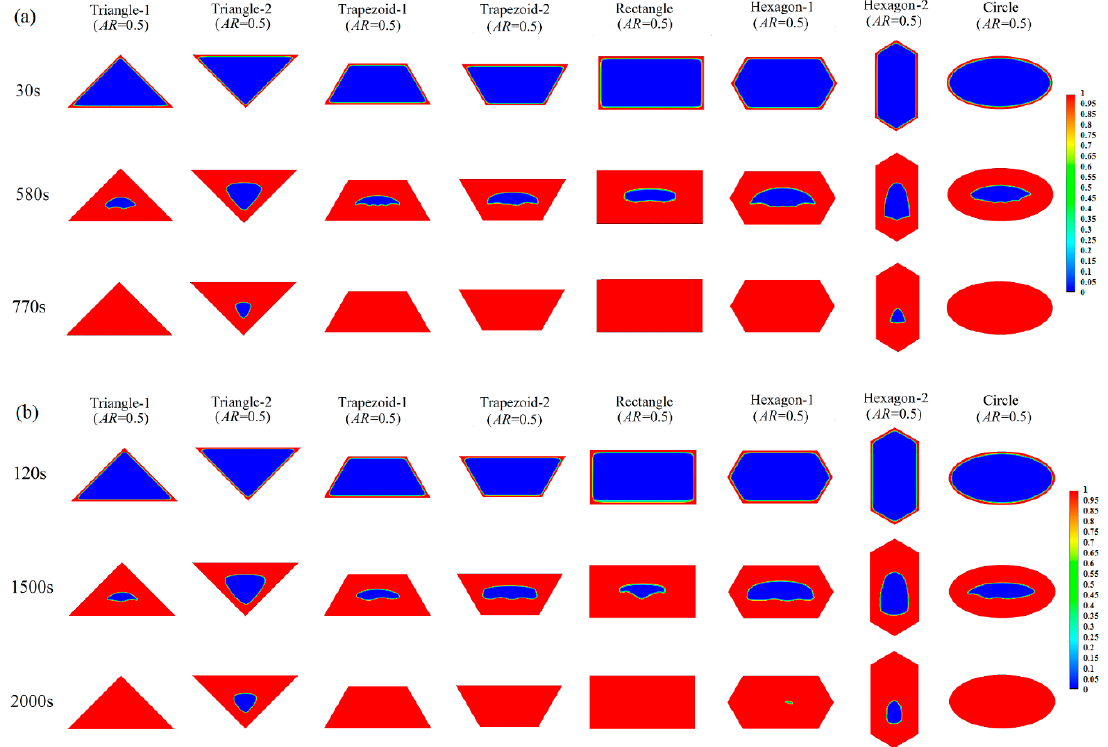
Figure A3. Liquid fractions of the triangular, trapezoidal, rectangular, hexagonal, and circular cells with smaller aspect ratios ( AR = 0.5). ( a ) Ra = 4.83 × 10 6 ( A = 625 mm 2 ); ( b ) Ra = 3.87 × 10 7 ( A = 2500 mm 2 ).